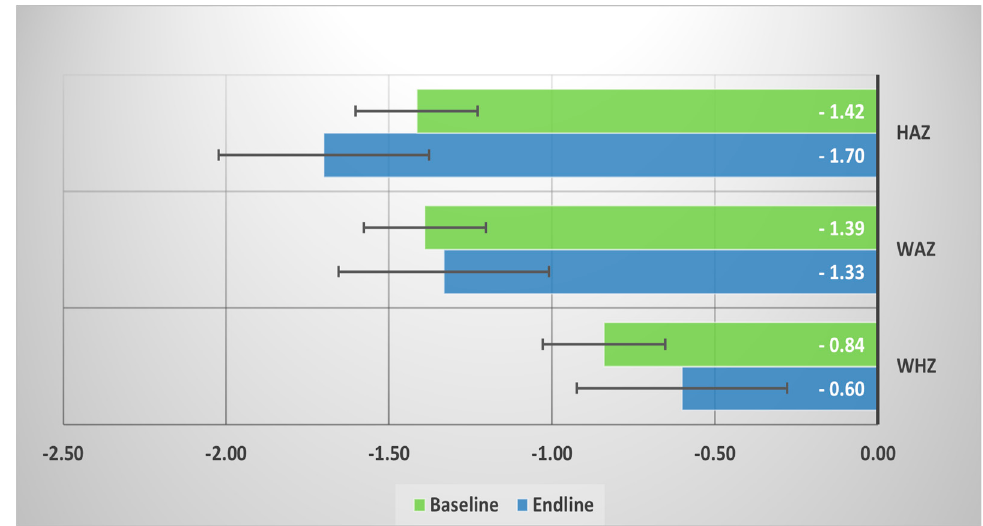
Figure 2. Mean baseline and endline height-for-age z-score (HAZ), weight-for-age z-score (WAZ), and weight-for-height z-score (WHZ) among the fecal NTS (+) children under